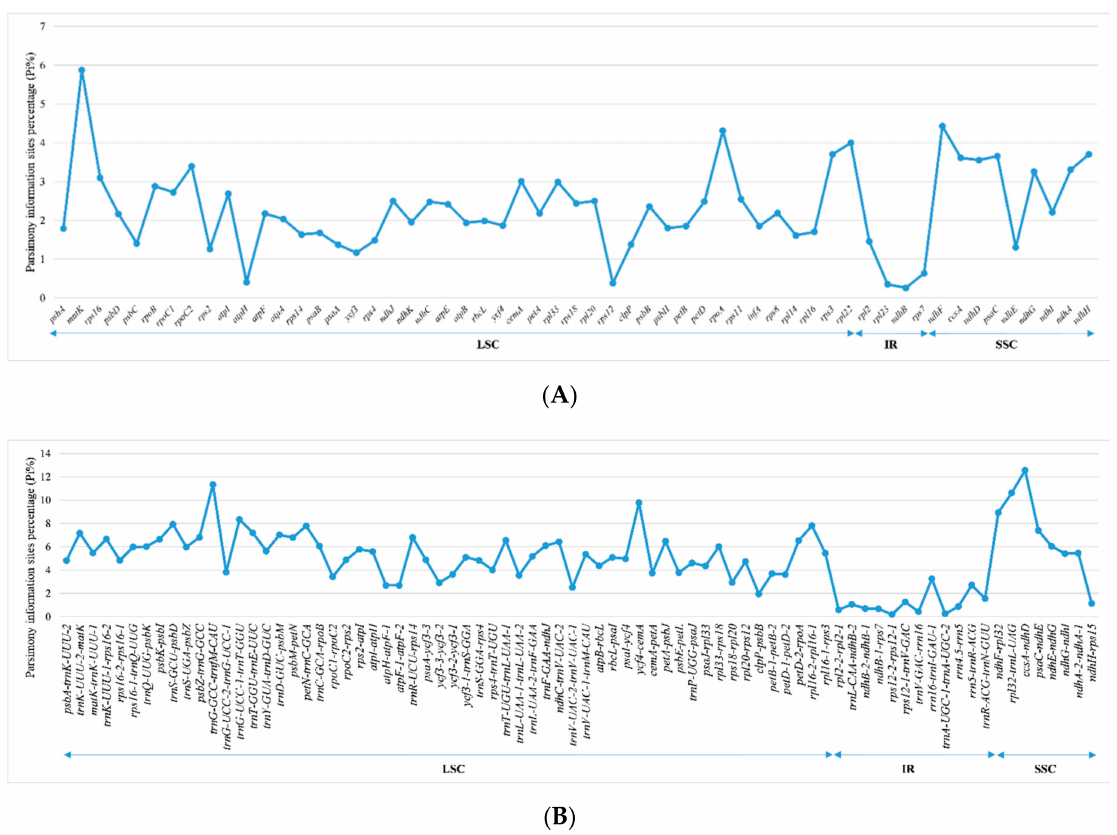
Figure 7. Comparison of percentage of parsimony information sites (Pi%) in 20 Eragrostideae chloroplast genomes. ( A ) Pi% values among coding sequences (CDS); ( B ) Pi% values among noncoding regions (IGS and intron